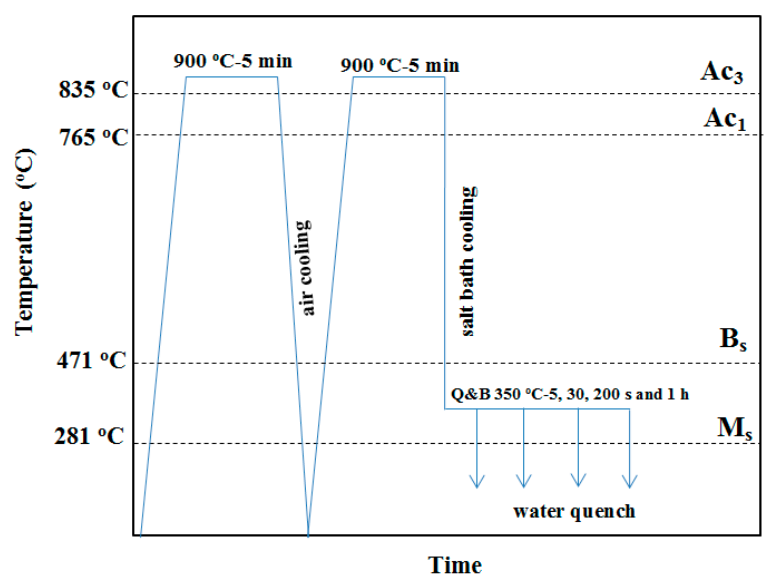
Figure 1. Schematic of Q&B heat treatment cycles carried out on sheet samples.